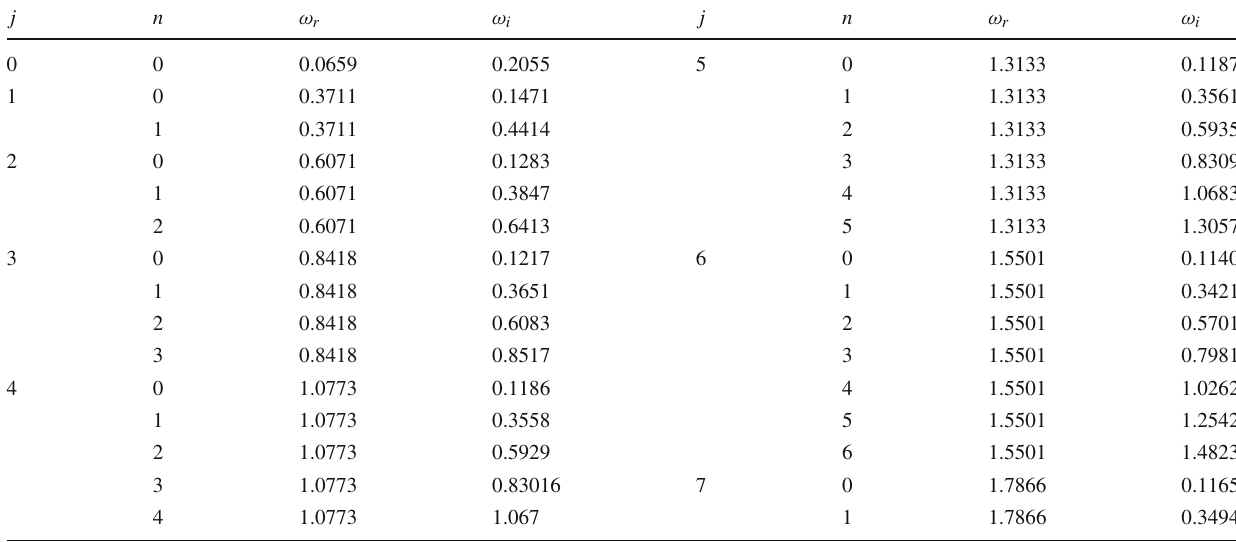
Table2 Thevaluesofthequasi-normalfrequenciesinthe(large)Schwarzschildgeometryforthevaluesofparameters r + = 1 . 5 , M = 0 . 57 ,α = 0 .